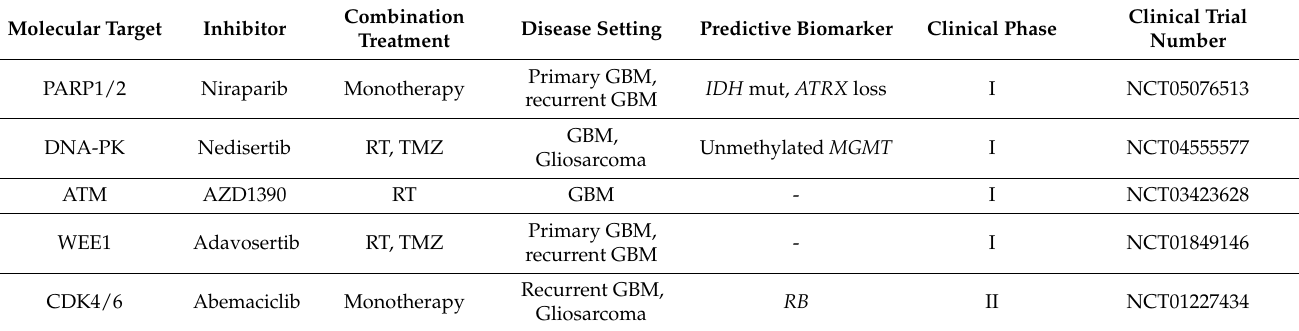
Table 3. Clinical trials that use small molecule inhibitor to target the DNA damage response